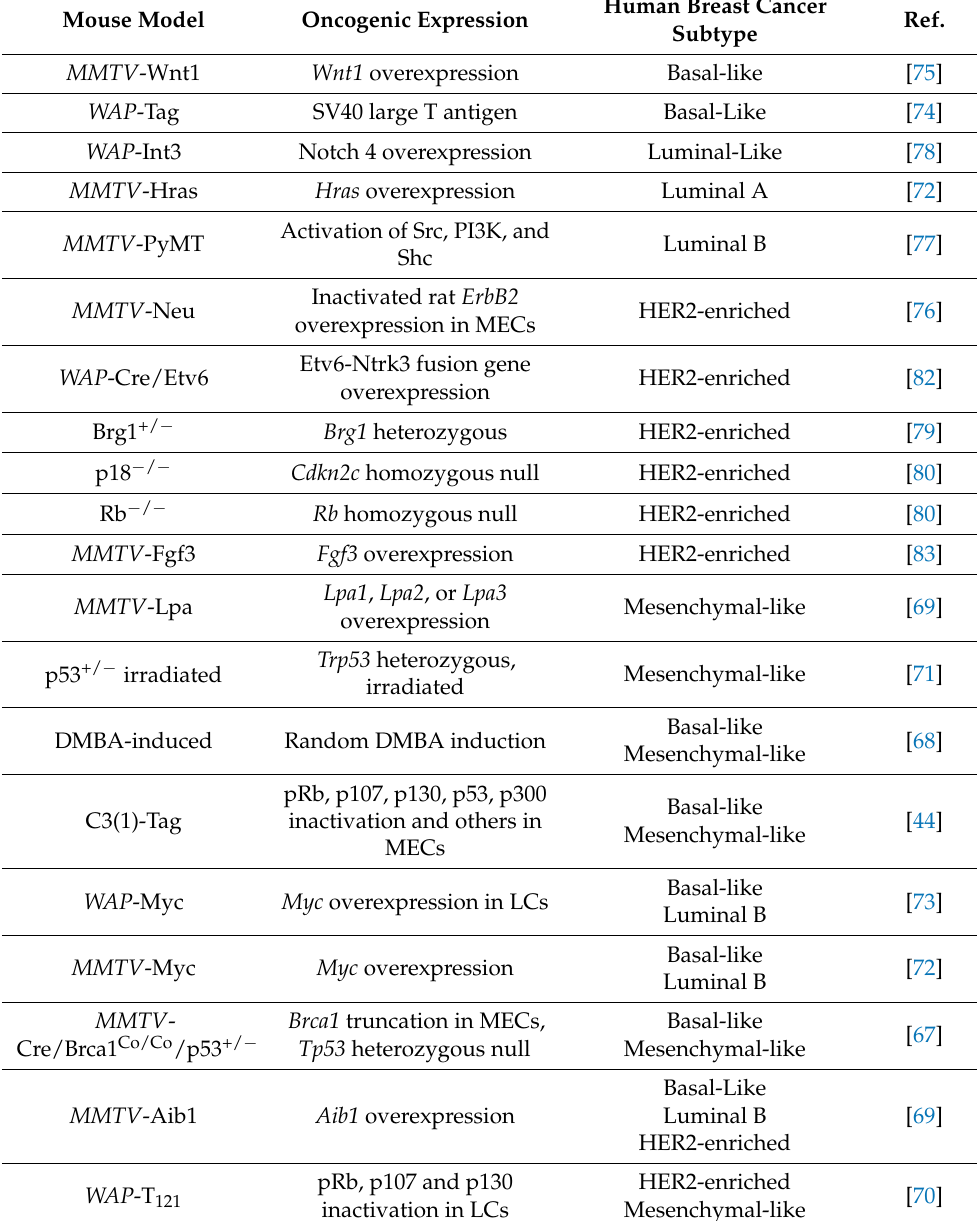
Table 1. Murine models that recapitulate different human breast cancer subtypes. This table summa- rizes the transcriptomic analysis performed in tumors derived from different murine in vivo models that are able to resemble specific human breast cancer